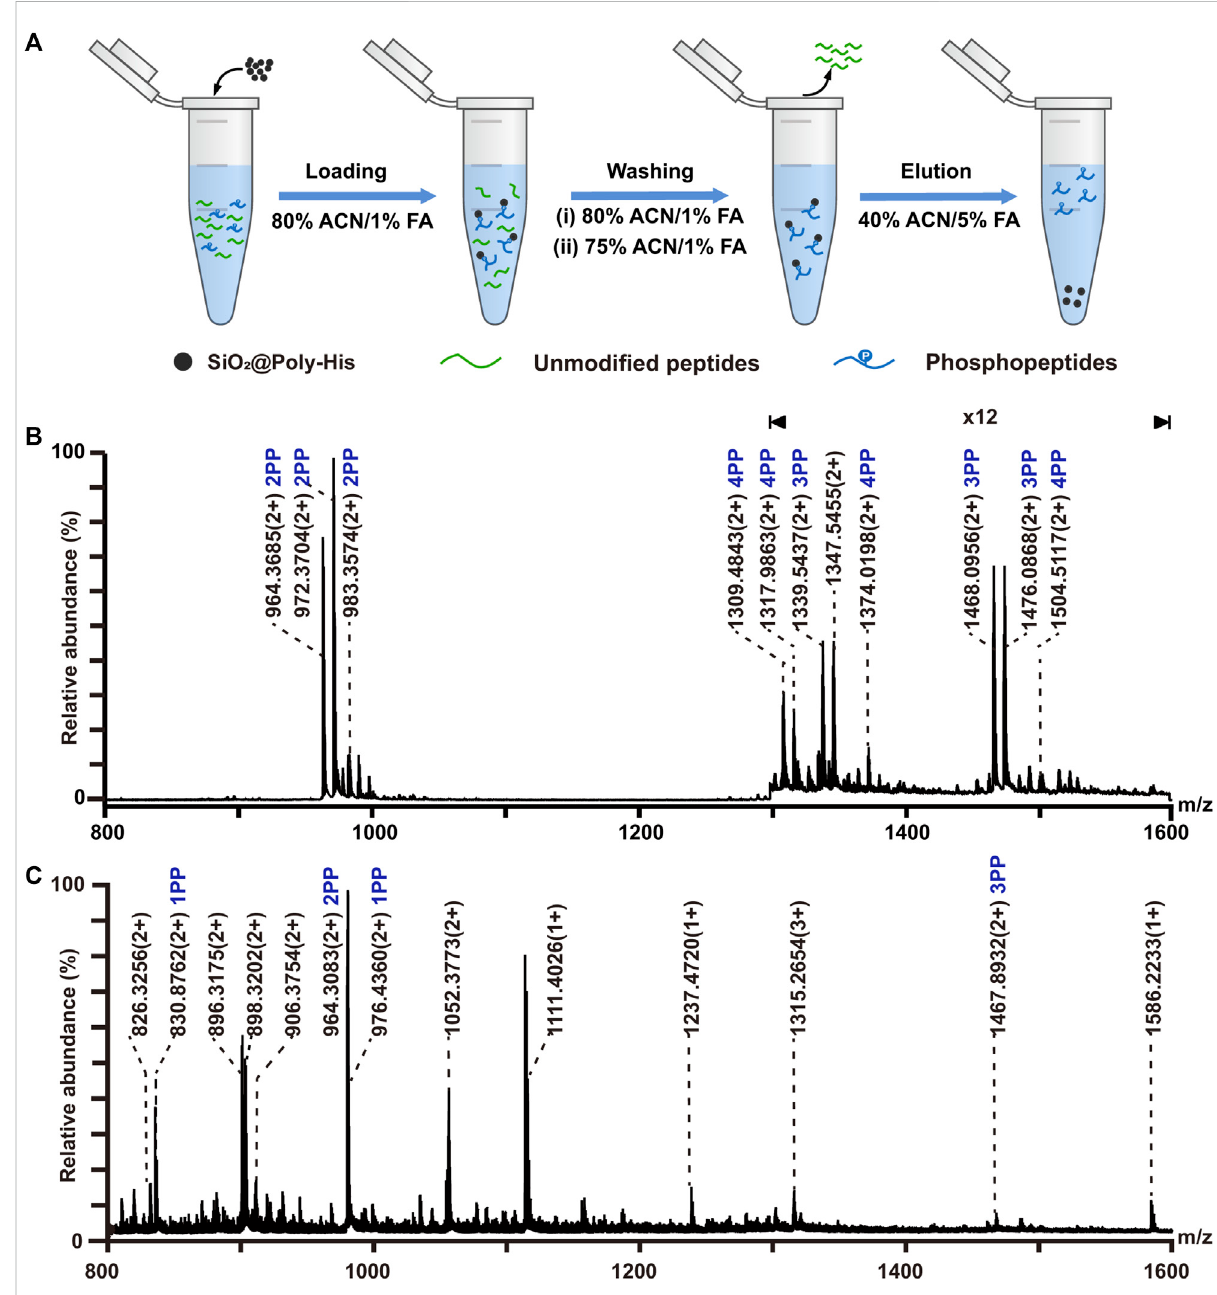
FIGURE 3 Enrichment of phosphopeptides with SiO 2 @Poly-His microspheres and commercial TiO 2 materials. (A) Work fl ow for the phosphopeptides enrichment with SiO 2 @Poly-His microspheres; (B) Mass spectrum of the mixture of the casein and BSA at molar ratio of 1:1,000 enriched by SiO 2 @ Poly-His microspheres; (C) Mass spectrum of the mixture of the casein and BSA at molar ratio of 1:1,000 enriched by TiO 2 . XPP represents phosphopeptide, among which X is the number of phosphate groups in a peptide; Only mass charge ratio (m/z) represents non-